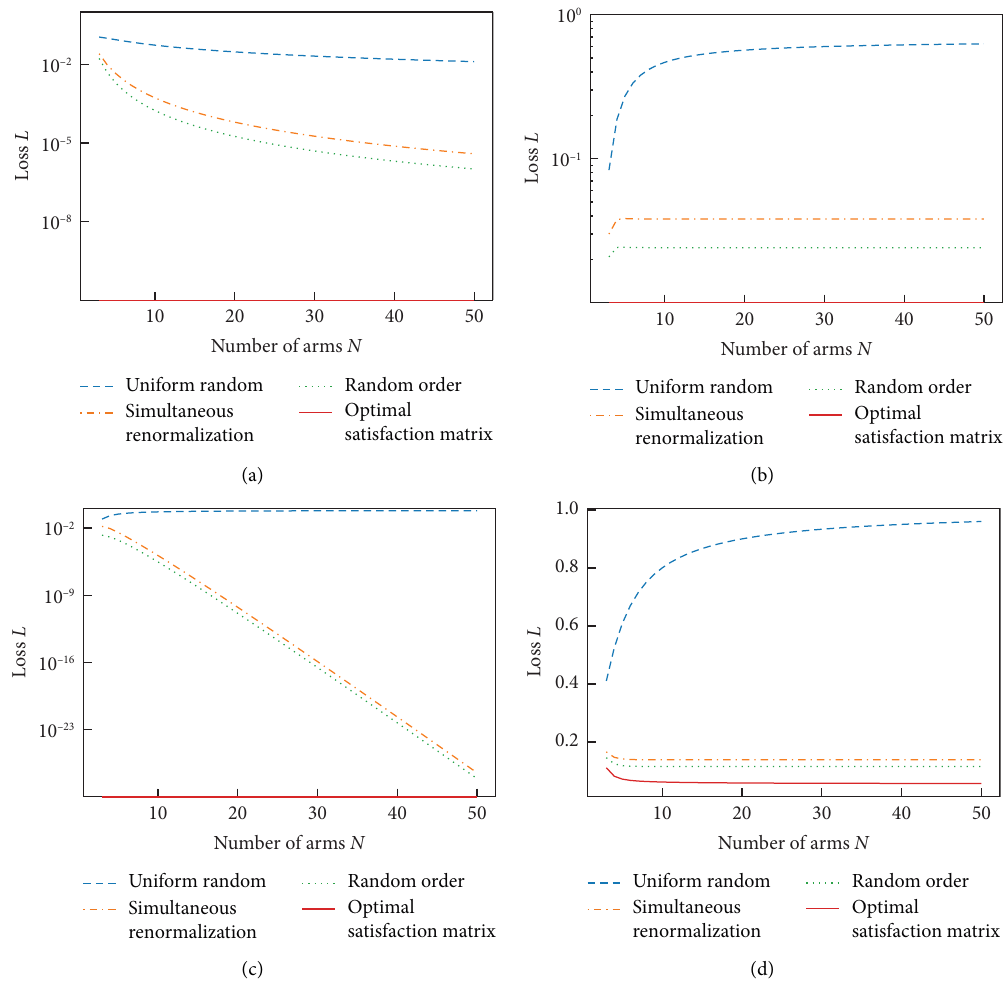
Figure 3: Loss comparison. Y axes are log scale for cases (1)–(3). Lines for the optimal satisfaction matrix overlap with X axes for these cases to show the loss is zero. (1) Arithmetic progression+same preference, (2) geometric progression with common ratio 2+same preference, (3) geometric progression with common ratio 2 +reversed preference, and (4) geometric progression with common ratio 3+ same preference. For cases (1)–(3), the minimum loss is zero, while for case (4), it is greater than zero. Table 4: Example of [Case 1].